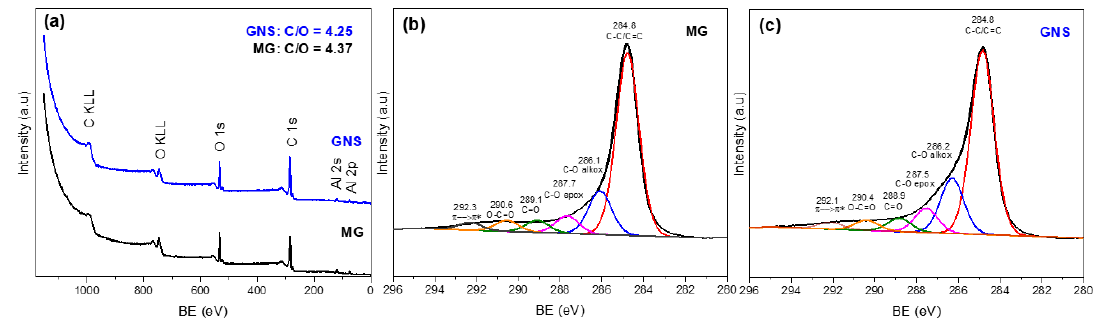
Figure 4. (a ) XPS survey for MG and GNS and XPS spectra for the C 1s photoemission peak of ( b ) MG and ( c ) GNS. Table 3. Contribution of the six components used in fitting of the C 1s photoemission peak (in %).